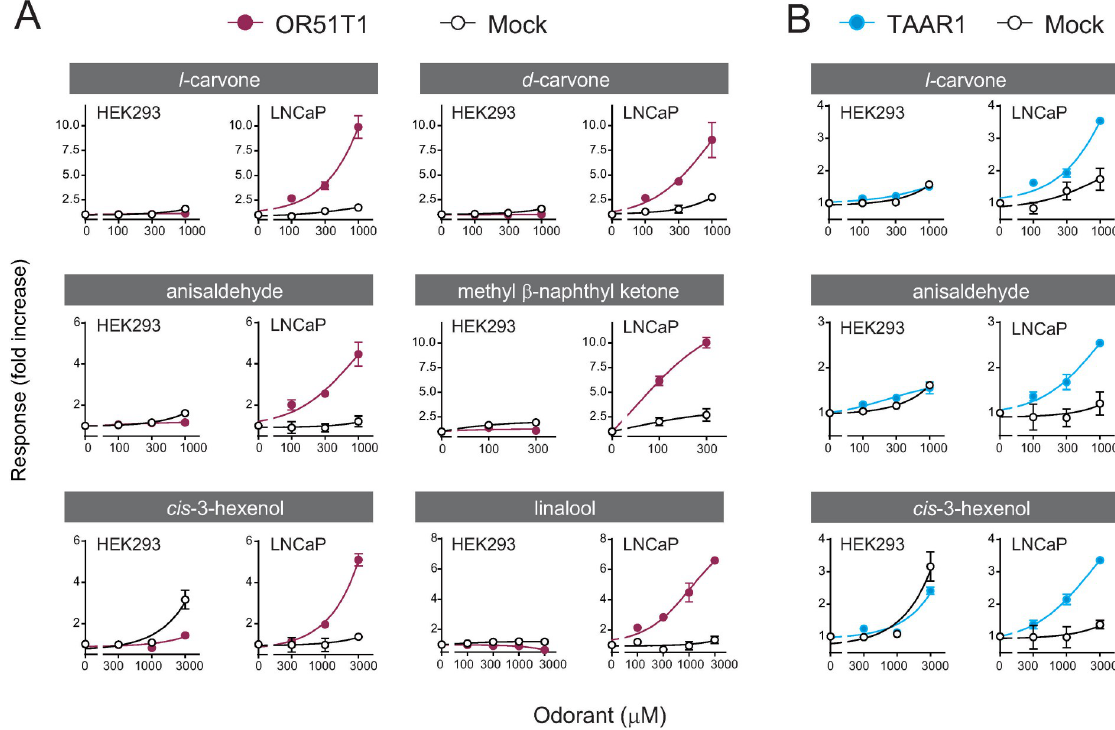
Fig 4. Identification of novel pairs of ligands and ORs in LNCaP cells. Dose-response curves of OR51T1 (A, magenta) and TAAR1 (B, blue) expressed in HEK293 (left) or LNCaP cells (right) against increasing concentrations of each odorant. Each OR in both cell lines was co-transfected with CRE/luc2PpGL4.29, pRL-CMV, RTP1S and G α olf. Ringer’s solution was used to dissolve the odorant mixture. Y-axis indicates the fold increase in response. Data are shown as mean ± SE of three independent experiments.